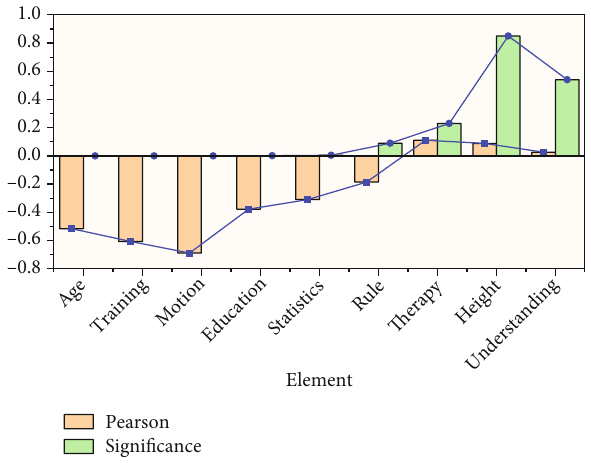
Figure 5: Statistical chart of sports injury